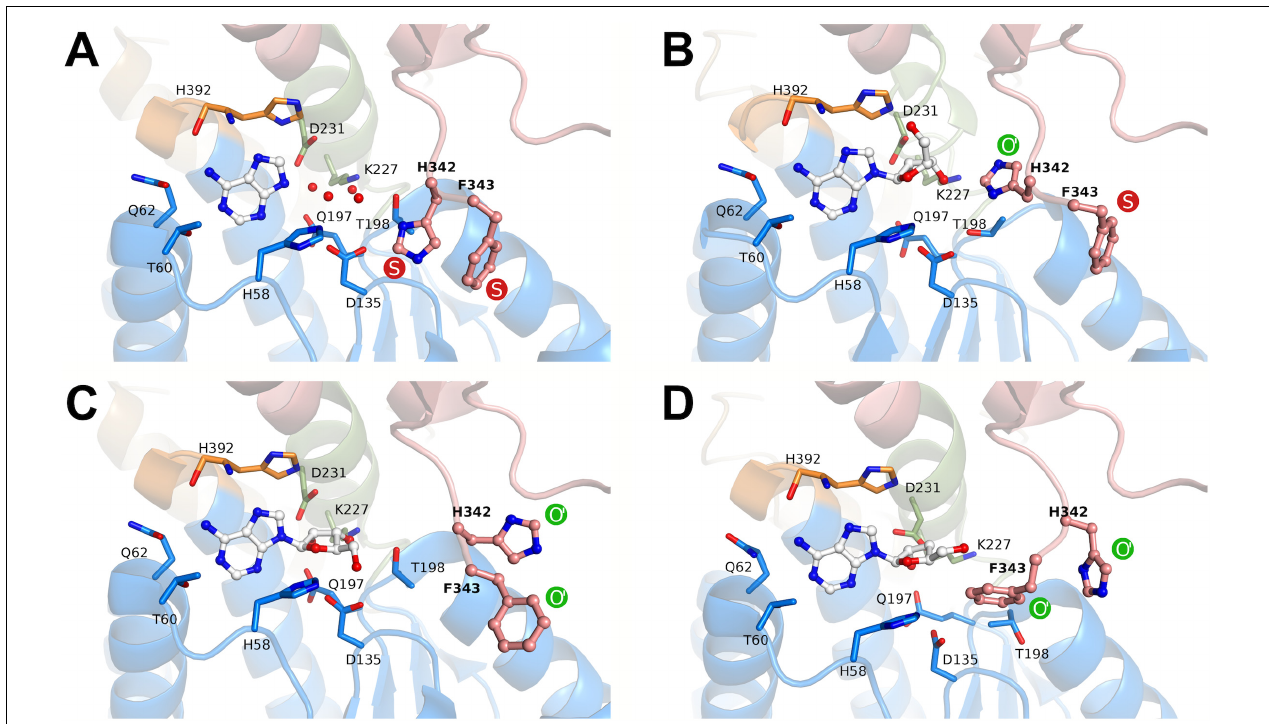
FIGURE 6 | Rotamers of the molecular gate residues His342-Phe343 in different states according to crystal structures of BeSAHase. The states are denoted as shut (S, red) and open (O, green). O (cid:48) represents variants of the first reported open state (PDB entry 4lvc; Manszewski et al., 2015). (A) In the PDB entry 5m65 (Manszewski et al., 2017), both side chains are in the shut state. (B) In the present structure (PDB entry 6exi) Phe343 is in the shut state, whereas His342 assumes a formerly unknown orientation of the open state. (C) In subunit A of the PDB entry 5m5k (Manszewski et al., 2017), both side chains are in variant orientations of the open state. (D) Further variants of open state orientations (subunit D of PDB entry 5m5k; Manszewski et al., 2017). The ligand molecules in the binding site are shown in ball-and-stick representation and residues involved in ligand binding are shown as sticks. The red spheres represent water molecules. The domains are color-coded as follows: blue, substrate-binding domain; salmon, cofactor-binding domain; green, Asn222–Leu233 and orange, His392–Val396 (interdomain hinge